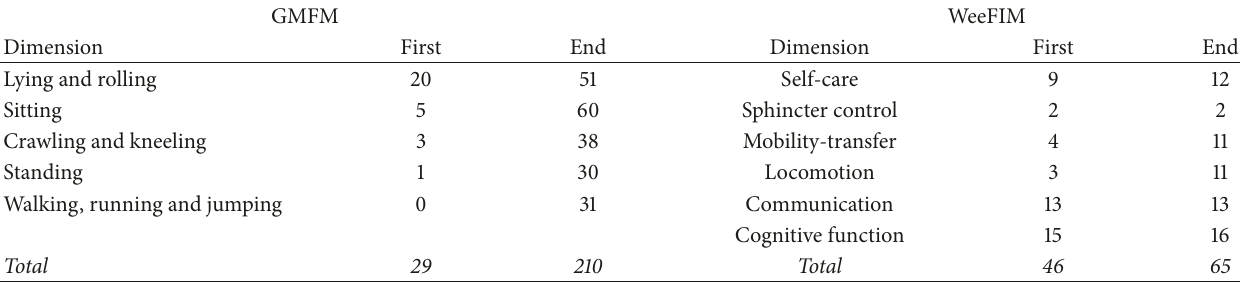
Table 3: Outcome of tests scores (GMFM and